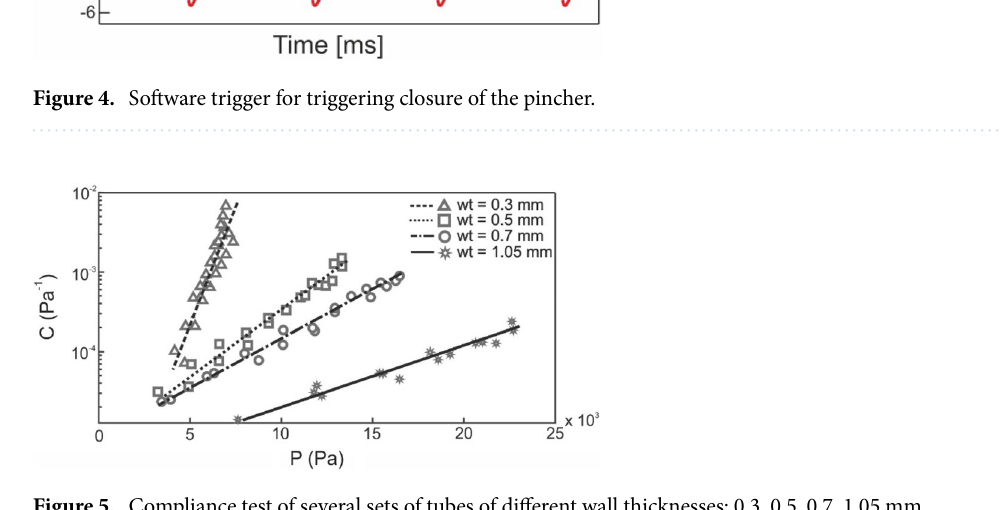
Figure 5. Compliance test of several sets of tubes of different wall thicknesses: 0.3, 0.5, 0.7, 1.05